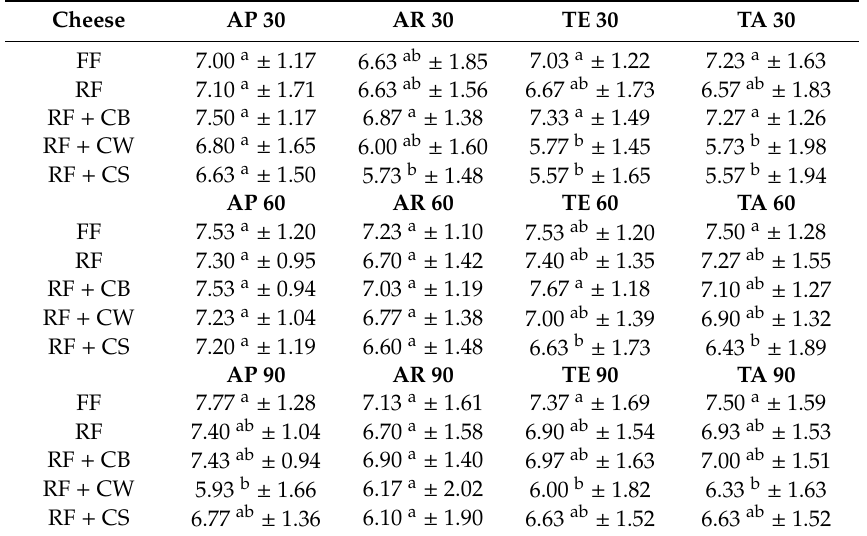
Table 3. Sensory evaluation of the cheese samples at the 30th, 60th and 90th days of ripening. Cheese